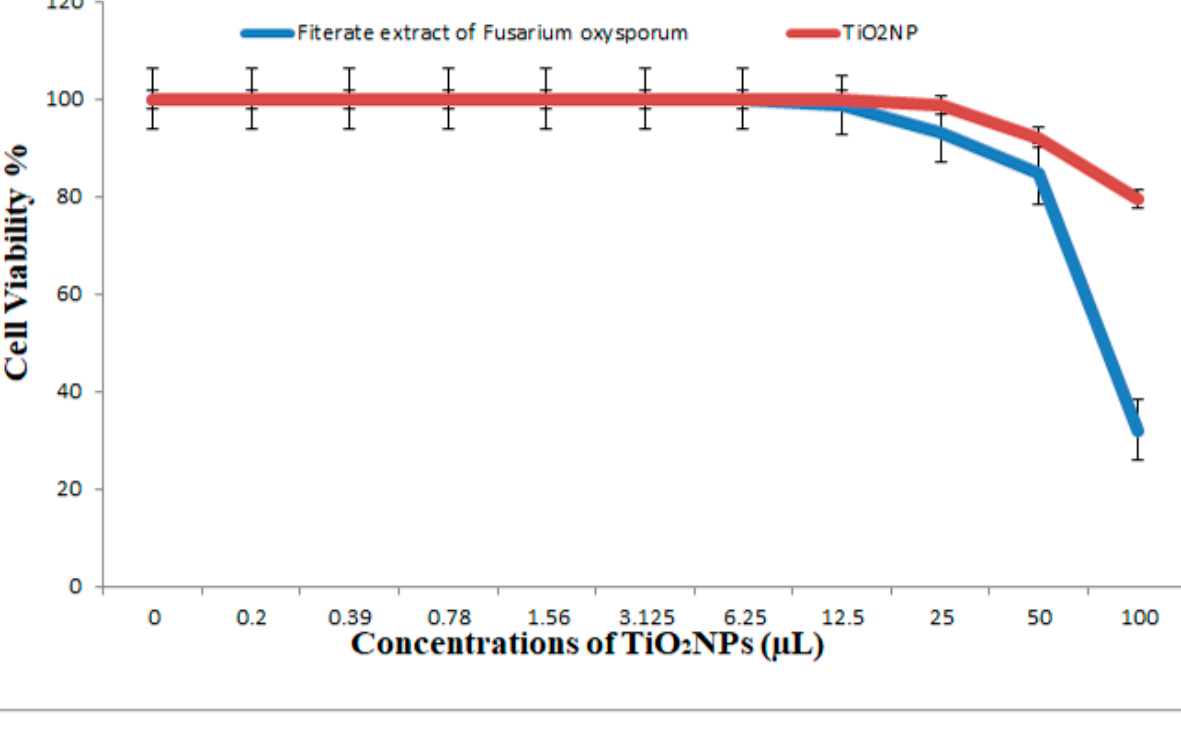
Figure 14. Viability of HCT-116 cells (colon carcinoma cell) (24 h incubation). Treatment with cell filtrate of Fusariumoxyspo- rium as control and treatment with titanium dioxide biosynthesized nanoparticles (TiO 2